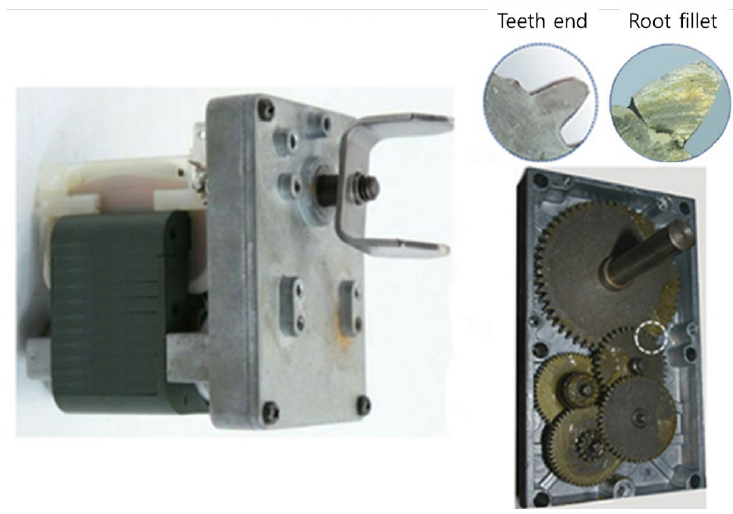
Figure 8. Damaged auger motor after usage.